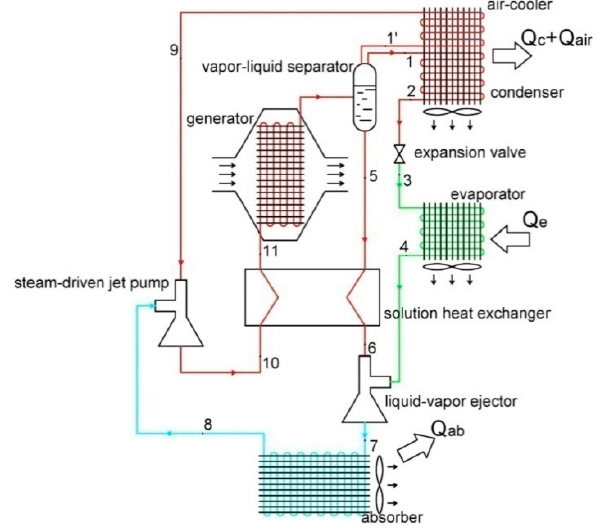
Figure 7. Proposed combined double ejector-absorption refrigeration cycle. Adapted from Liang et al. [84] (Reprinted with permission from Elsevier).